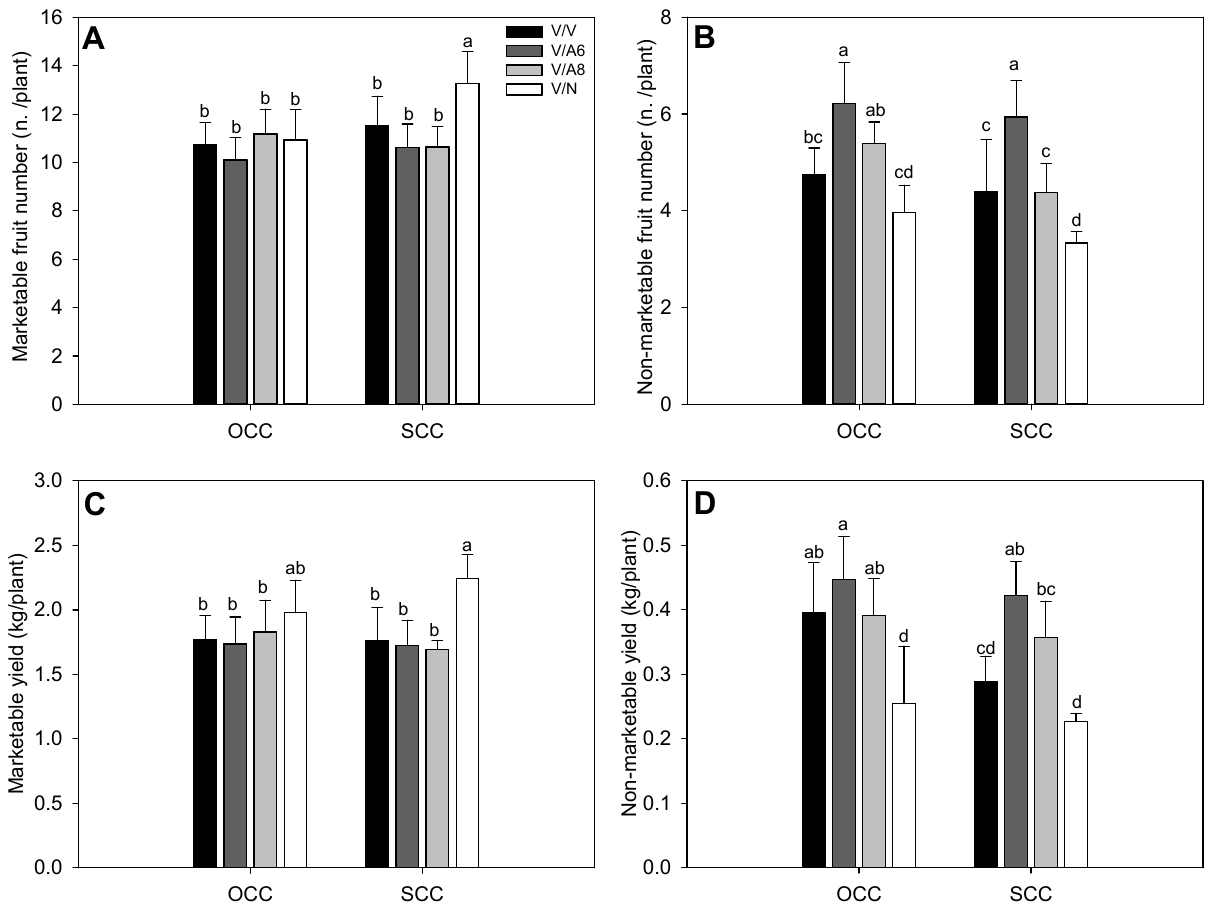
Figure 1. Number of marketable ( A ) and non-marketable ( B ) fruits per plant, marketable ( C ) and non-marketable ( D ) fruit yield (Kg/plant) under optimal (OCC) and suboptimal (SCC) calcium conditions. The selected variety (V) was grafted onto the rootstocks A6 (V/A6), A8 (V/A8) and NIBER ® (V/N), as well as self-grafted (V/V). Data are the mean values of n = 4 and bars correspond to the standard deviation. Different letters indicate significant differences at P < 0.05 (LSD